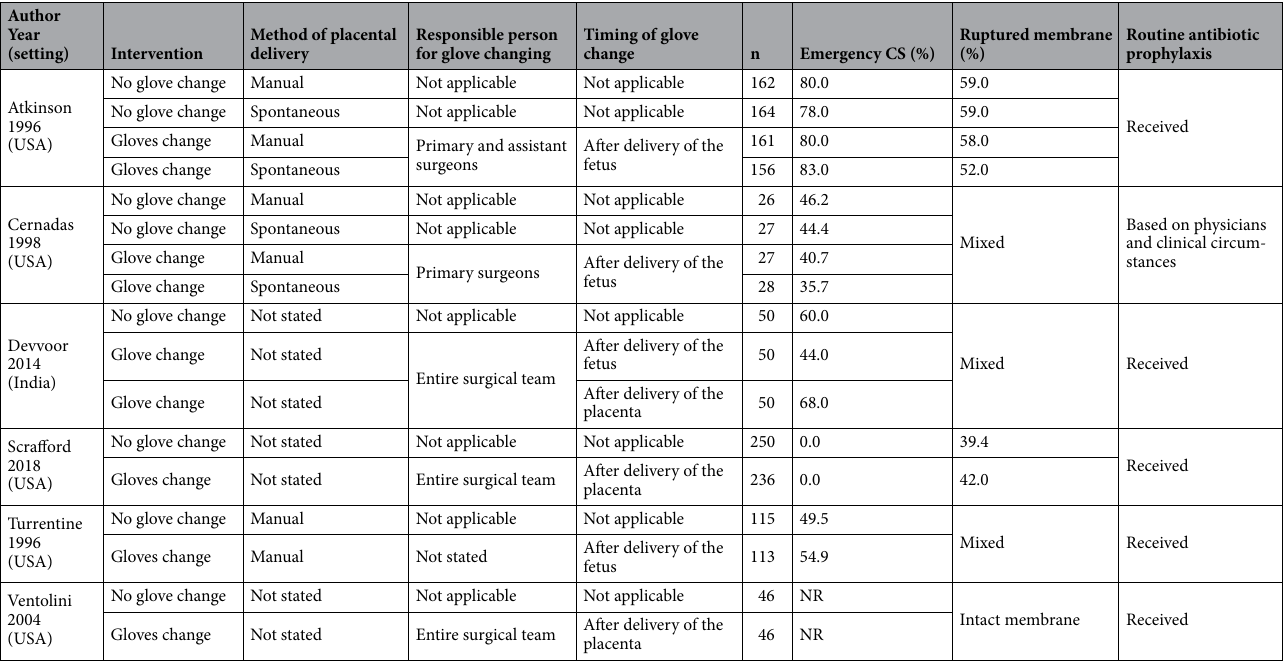
Table 1. Characteristics of the included studies. N, number of participants; CS, cesarean section; USA, United States; Manual, Manual placental removal method; Spontaneous, Spontaneous placental removal method; NR, not